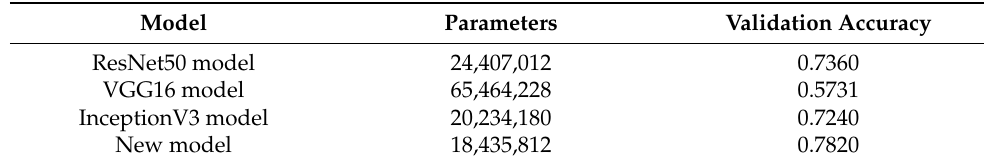
Table 3. Validation accuracy and the number of parameters of 100 Sport classification images performed with four different classification models.